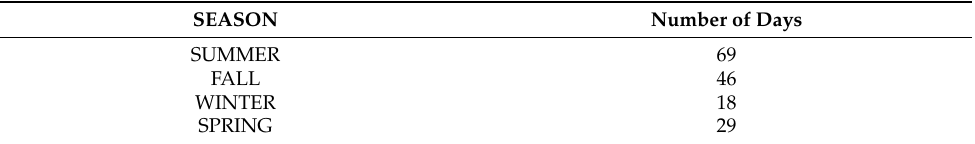
Table 1. Distribution of the selected days among the seasons.